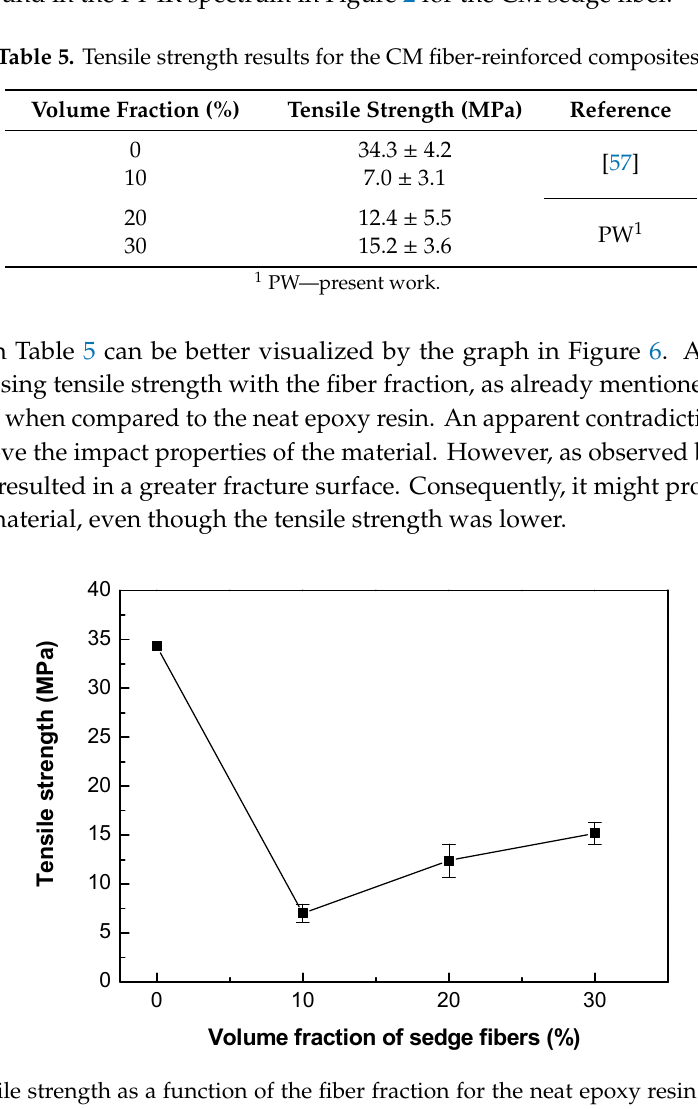
Table 6. Analysis of variance for the tensile strength of the CM sedge fiber-reinforced composites.